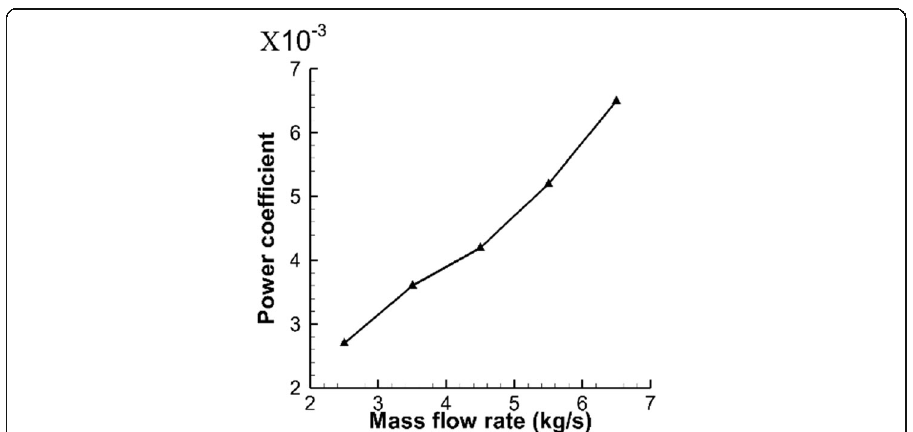
Fig. 10 The power coefficients of the optimized diamond airfoil with different mass flow